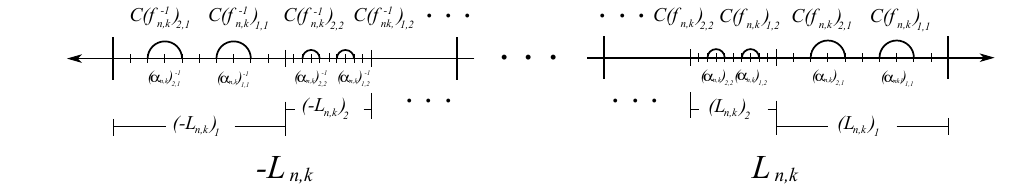
Figure 15: The closed intervals − L n , k and L n , k